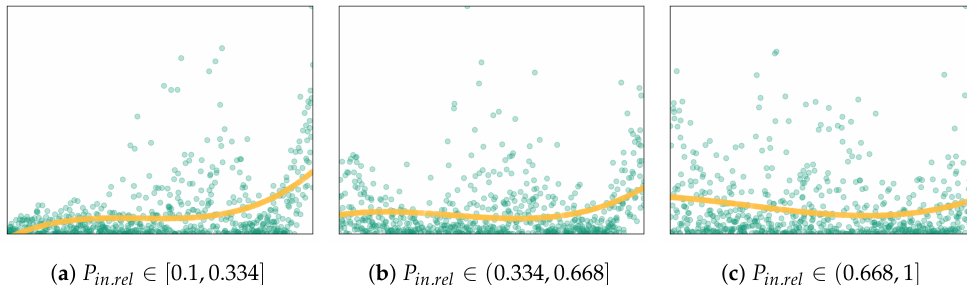
Figure A2. Scatterplots (blue) of squared OLS residuals ˆu 2 (y-axis) against feature P in , rel (x-axis) for the charging state data sets. The Breusch–Pagan test suggests heteroscedasticity for all three data sets (as the orange prediction lines are not